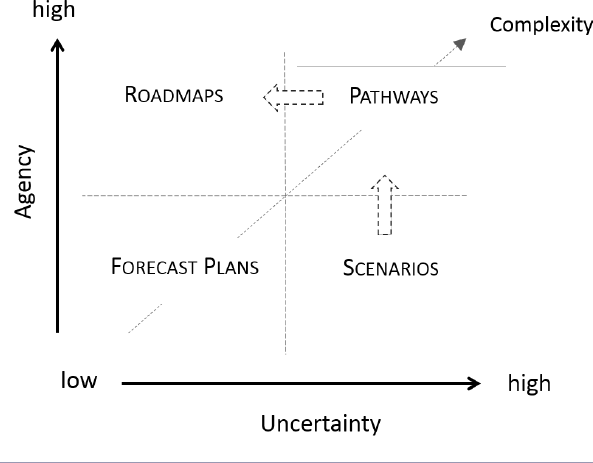
Fig. 1 . The different kinds of tools for working with the future. The horizontal axis represents the degree of uncertainty about the future; the vertical axis represents the extent to which the tools enhance a degree of agency. Four domains indicate the relative strengths of different tools and approaches. For example, scenarios are generally most useful when the future is highly uncertain, but often on their own have limited capacity to identify strategies for achieving different futures. Roadmaps tend to be most useful in circumstances where there is greater certainty, where they provide clearer directions for change. New pathways approaches are emerging, which aim to enhance agency in situations of high uncertainty. The arrows indicate that some scenario approaches, depending on how they are applied, also can work well in the high uncertainty and high agency domain, and that many existing pathways approaches are aligned more closely with